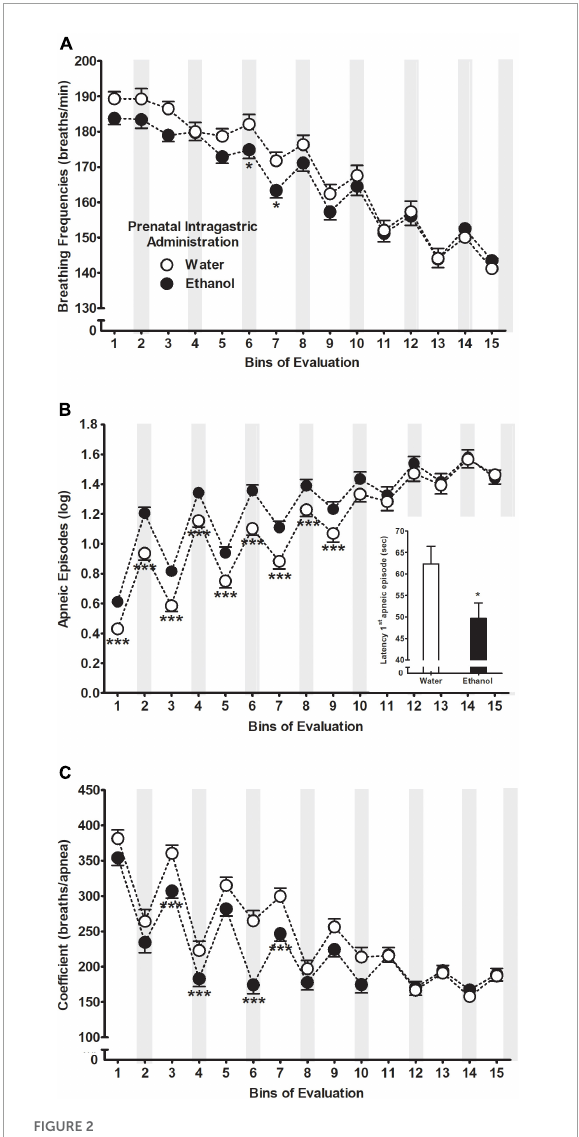
FIGURE2 (A) Breathing frequencies, (B) apneic episodes, and (C) total number of breaths until an apnea occurrence (coefficient: breaths/apneas) as a function of prenatal intragastric administration of ethanol (black) or water (white) across bins of evaluation. Gray bars indicate intraoral infusions during the artificial lactation test. * p < 0.05 and *** p < 0.001 significant differences between groups within a time point. Data were collapsed across postnatal days of assessment. The latter did